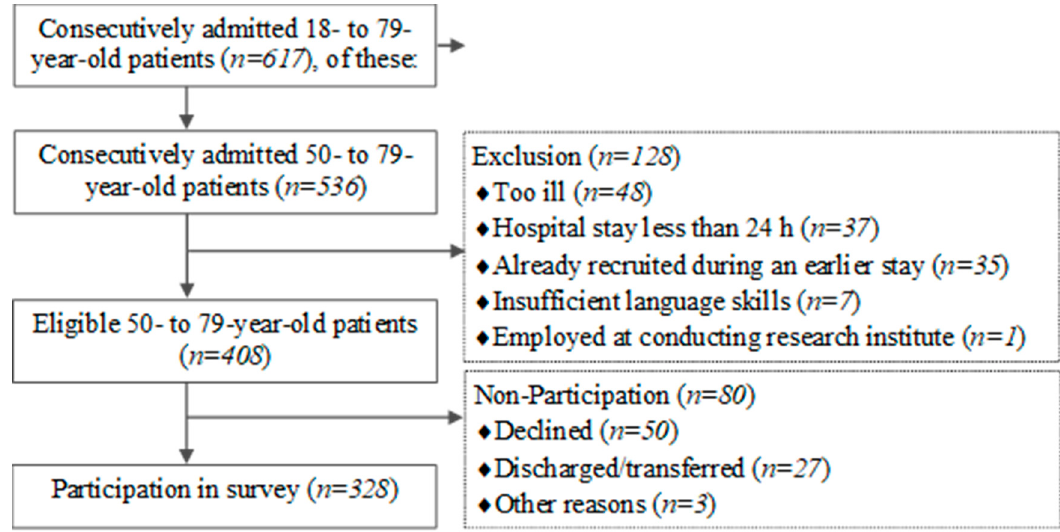
Figure 1. Participant flow chart.